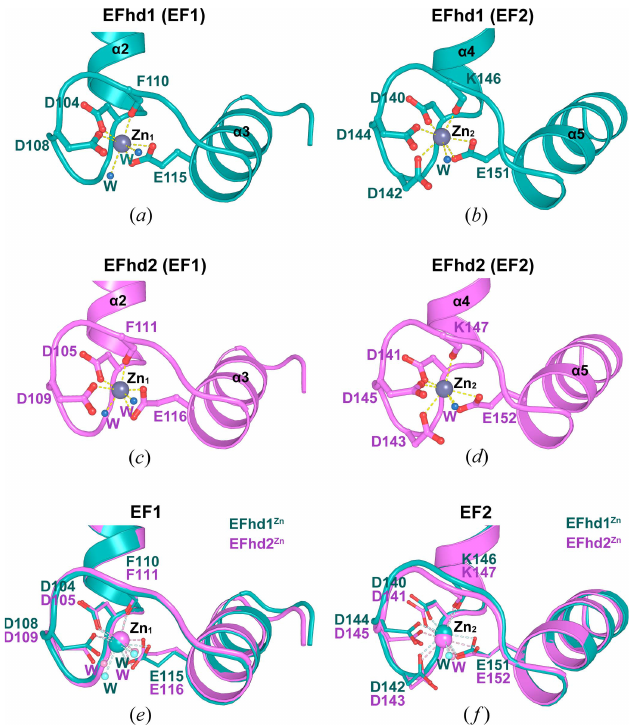
Figure 3 Structural comparisons of the EF-hands between EFhd1 Zn and EFhd2 Zn . ( a ) and ( b ) Detailed illustrated views of ( a ) EF1 and ( b ) EF2 in EFhd1 Zn with Zn 2+ bound. EF1 and EF2 are shown in teal. Zn 2+ and water are shown as dark gray and sky blue spheres, respectively. ( c ) and ( d ) Detailed illustrated views of ( c ) EF1 and ( d ) EF2 in EFhd2 Zn with Zn 2+ bound. EF1 and EF2 are shown in magenta. Zn 2+ and water are shown as dark gray and sky blue spheres, respectively. ( e ) and ( f ) Detailed illustrated view of superimposed ( e ) EF1 and ( f ) EF2 from EFhd1 Zn and EFhd2 Zn . Zn 2+ is shown as teal (EFhd1) and magenta (EFhd2) spheres. Water molecules are showed as pale teal and pale magenta spheres. In all panels, the residues for Zn 2+ coordination are shown in stick form, and Zn 2+ coordination is represented by dashed